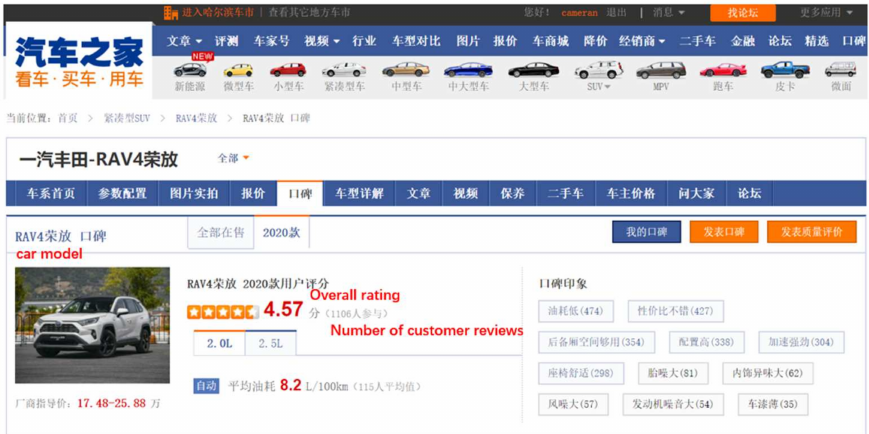
Figure 3. Overall rating and review volume for Toyota